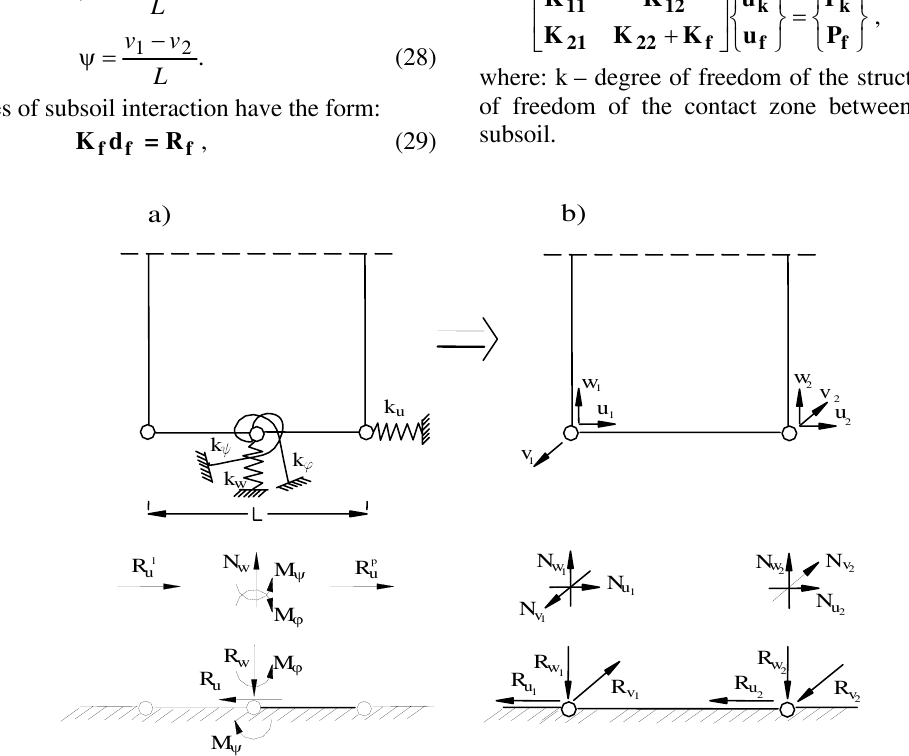
Fig 4 . The subsoil interaction in the elastic contact model: a) elastic constrains, b) soil-structure